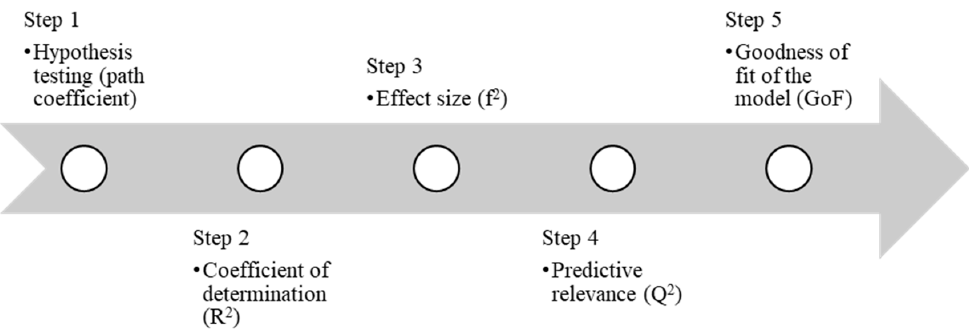
Figure 5. Structural model assessment procedure.